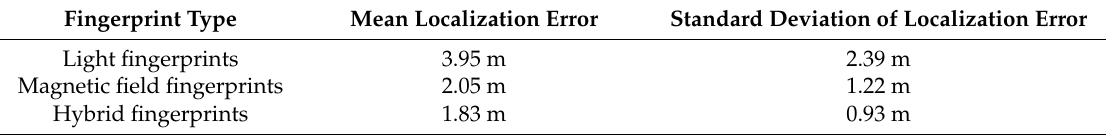
Figure 20. Localization accuracy of LiMag using different fingerprint types in sunlight interference areas. Table 3. The localization error in sunlight interference scenario using different fingerprints.